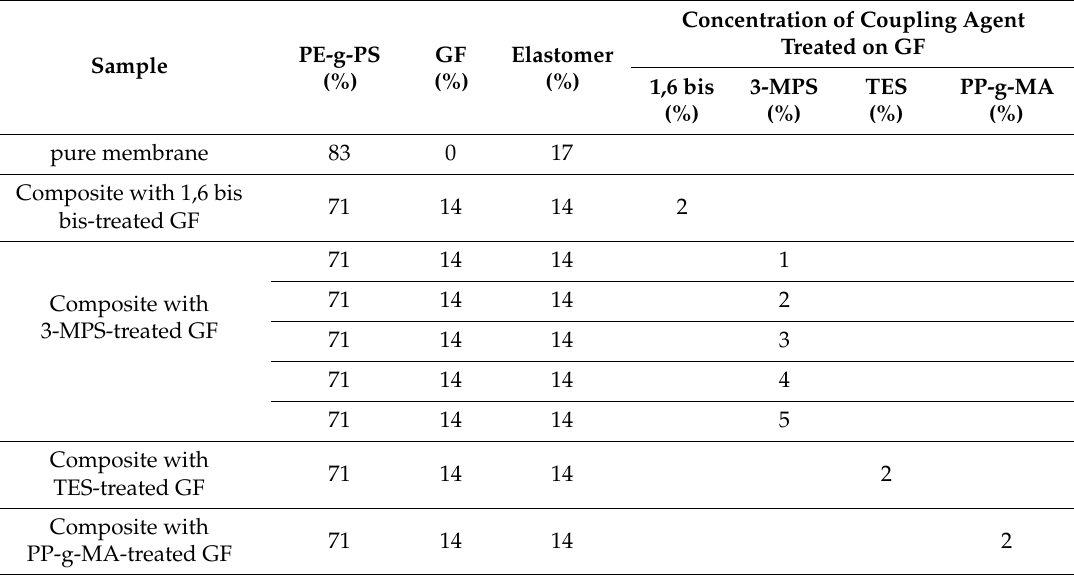
Figure 1. Chemical structure of coupling agents and their hydrolyzation mechanism. Table 1. Formulation of